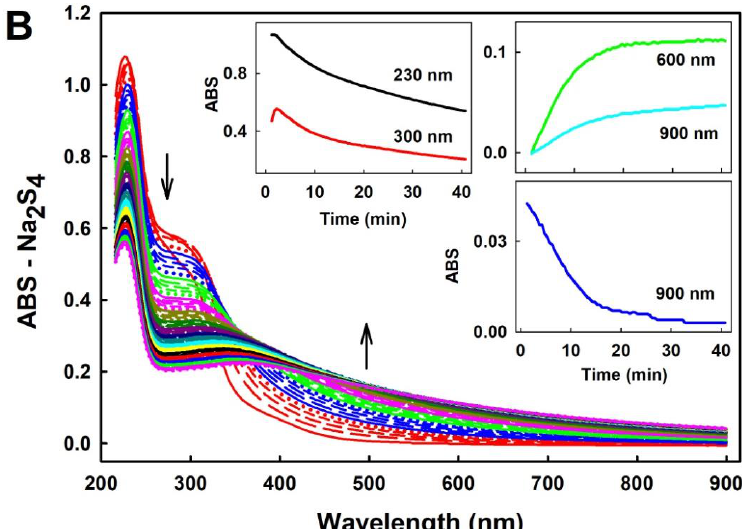
Figure 2. Representative time-dependent UV-VIS spectra of 100 µM Na 2 S 3 (A) and 100 µM Na 2 S 4 (B) in 100 mM sodium phosphate, 100 µM DTPA, pH 7.4, at 37 °C. Spectra were recorded every 30 s for 40 min. The first spectrum was recorded 15 s after thawing of 10 mM Na 2 S 3 or 10 mM Na 2 S 4 stocks. Arrows indicate decrease of ABS at 280 nm and increase at 500 nm. For details on colors, see Figure 1. Insets: Kinetics of changes in ABS at 230 nm (black), 300 nm (red), 600 nm (green) and 900 nm (cyan). After 40 min incubation of Na 2 S 3 or Na 2 S 4 samples (A, B), 100 µM • cPTIO was added and the spectra were recorded for further 40 min. Kinetics of decrease of ABS at 900 nm after addition of 100 µM • cPTIO (time zero) to 40 min incubated Na 2 S 3 or Na 2 S 4 samples are shown as Insets–blue lines.